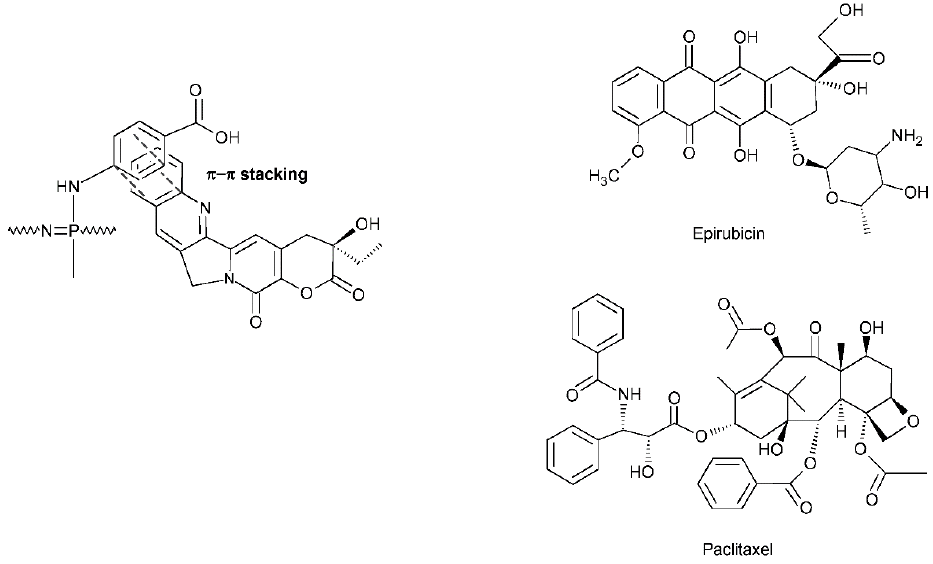
Figure 16. The π – π stacking between the polyphosphazene and camptothecin. Epirubicin and paclitaxel can give similar π – π stacking with the polymeric chain.